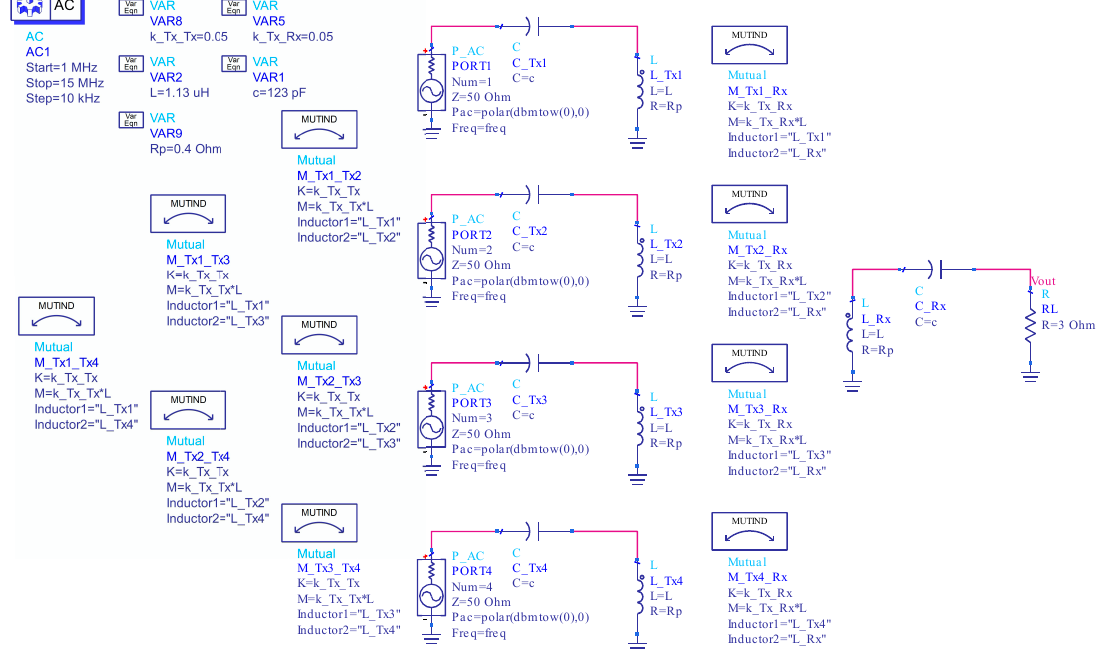
Figure 1. Schematic diagram of a multiple-input single-output (MISO) wireless power transfer (WPT) system for the advanced design system (ADS) circuit simulation.